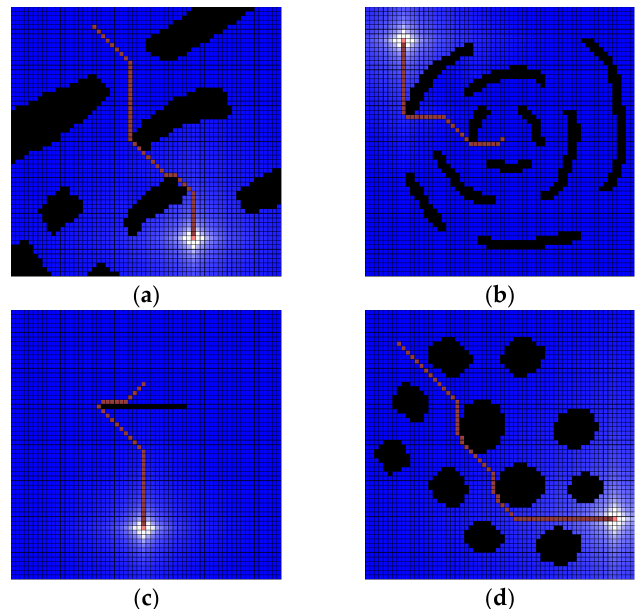
Figure 12. Several results of water sink model. The cell size is 10 (pixels) and 60 × 60 cells map. The drainage water is 1000 per turn. All experiments show that the robot (pink-colored cell) reached the plughole (white-colored cell) with the shortest path on the grid metric. As a result, the plughole is obscured by the robot: ( a ) test map-1 for water sink model; ( b ) test map-2 for water sink model; ( c ) test map-3 for water sink model; ( d ) test map-4 for water sink model.